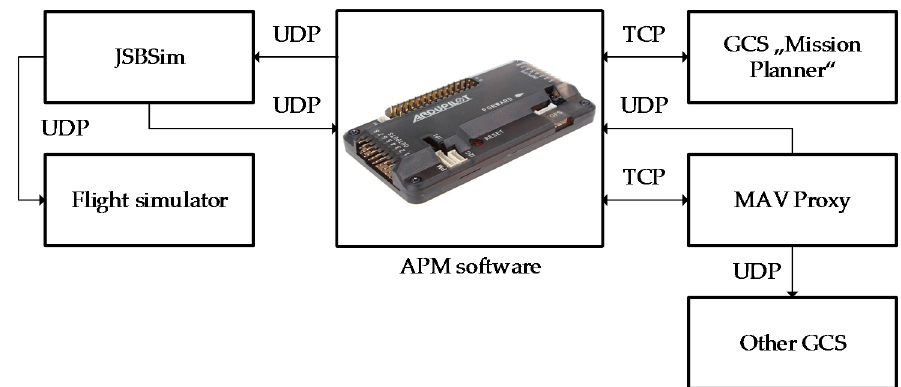
Figure 7. Software-in-the-Loop simulation setup.